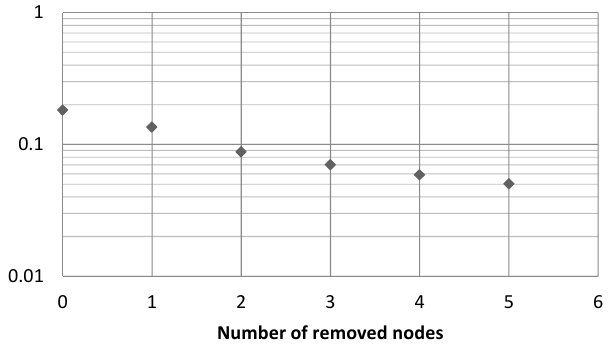
Figure 17. The change of the network e ffi ciency during analysis. Figure 17. The change of the network efficiency during analysis. Figure 17. The change of the network efficiency during analysis. Figure 17. The change of the network efficiency during analysis.